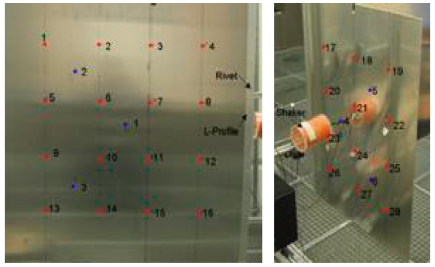
Figure 4: PIM method measurement point